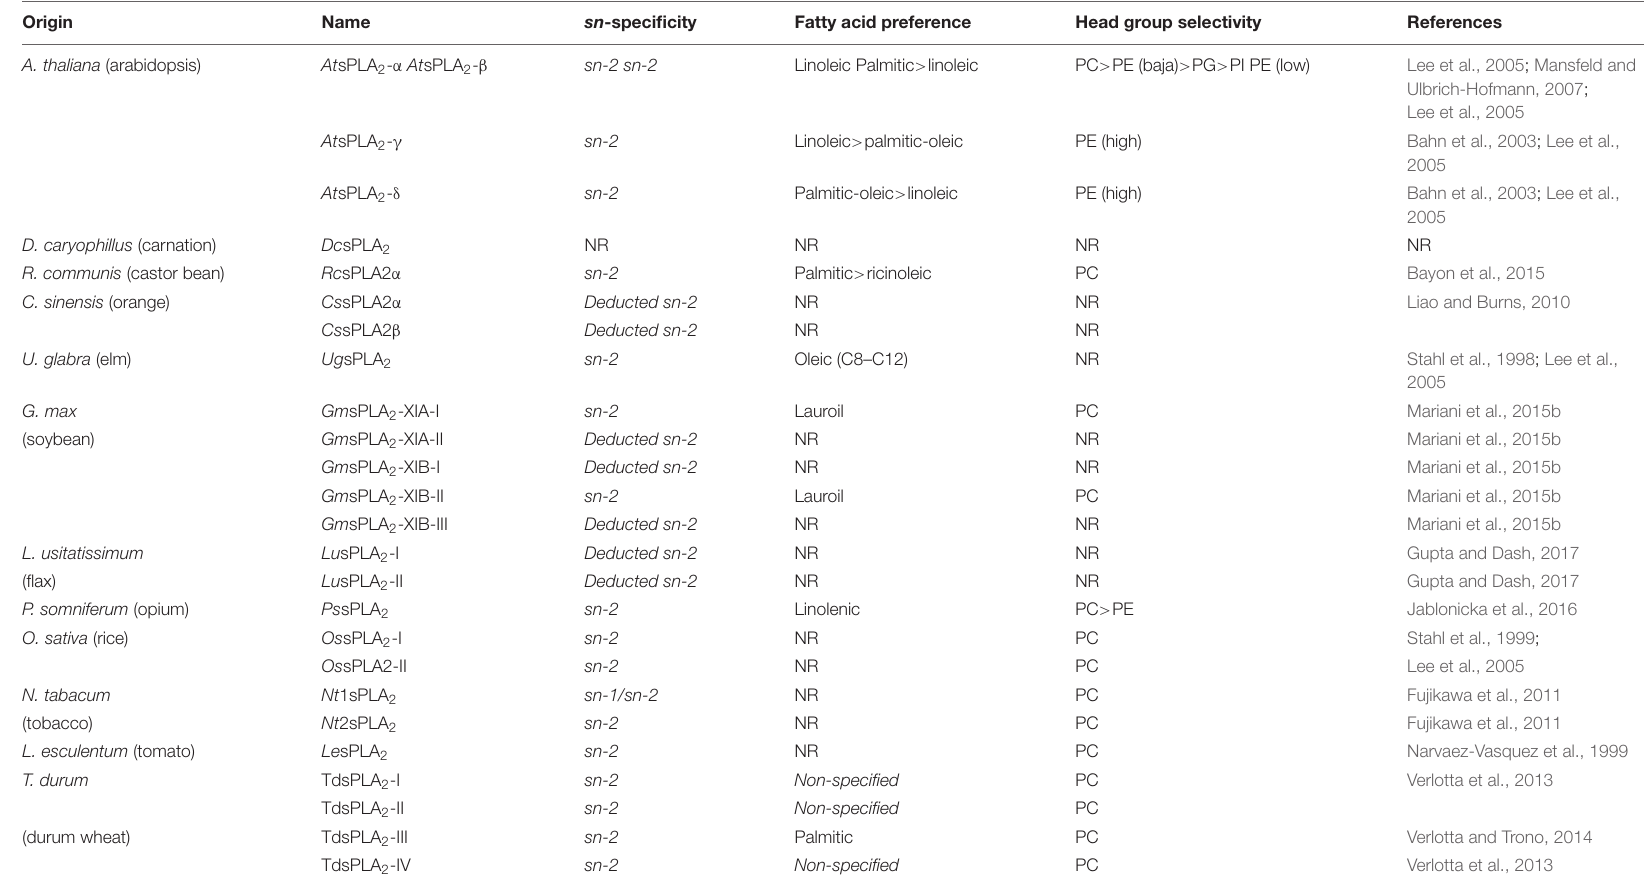
TABLE 8 | Substrate preference of different sPLA 2 s from